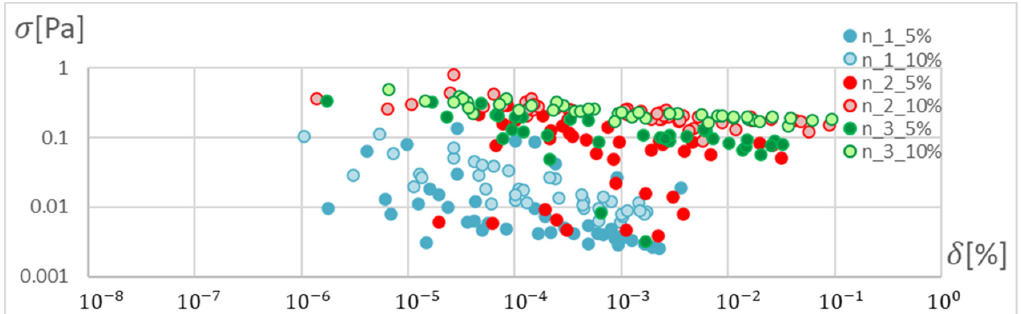
Figure 19. Pareto front for the two best-matched networks trained using the RPROP algorithm. Figures 12–19 present the Pareto fronts for selected neural networks for two variables (absolute value of the average relative error 𝛿 and its standard deviation 𝜎 ). As a result of the research, it was noticed that the increase in the number of hidden layers reduces the span impact of the training database on the accuracy of the results. However, the more layers the network has, the lower the accuracy. This may be caused by an insufficiently large sample of learning data; however, for a single-layer network, the learning accuracy is satisfactorily high. For both training methods (SCG and RPROP), the Pareto front points for a neural network with one hidden layer at the data span have the smallest relative error values. In the case of the RPROP algorithm for networks with one and two hidden layers, for data ±5% , the Pareto fronts are arranged parallel to each other, creating bands of similar width, with a smaller average error of the network with a single hidden layer. For the SCG algorithm, the front band for a single-layer network looks similar to a net- work trained with the RPROP algorithm, but the band for a two-layer network is much